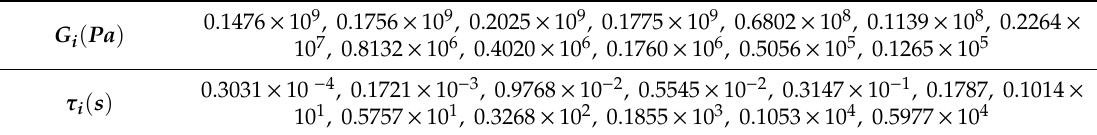
Table 2. Parameters of constitutive model of SMP: shear moduli and associated relaxation times G i ( Pa